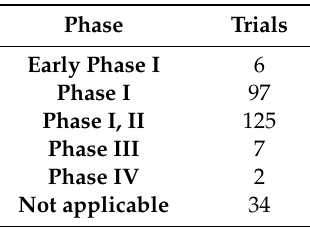
Figure 2. Map of clinical trials on adipose stem cells in the world [11]. East Asia is the highest number of trials, following by Europe, North America, and the United States. Table 1. Phase of adipose stem cell trials from 2007 to 2019